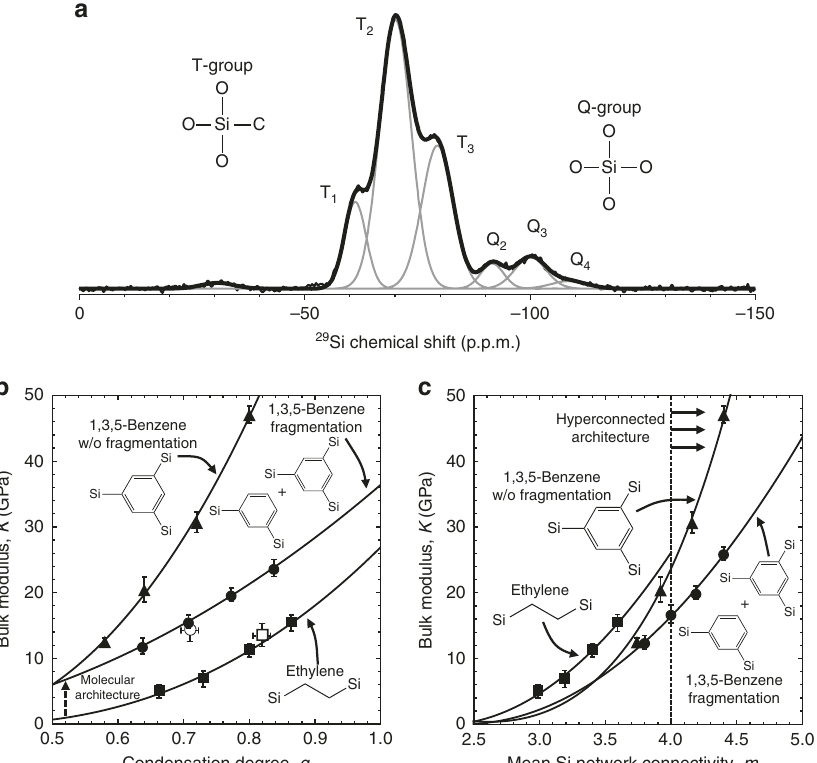
Fig. 2 Synthesized glasses calibrate and con fi rm computational models. a The 29 Si NMR spectra for glass processed from 1,3,5(triethoxysilyl)benzene shows the majority of silicon atoms are coordinated with three oxygen atoms and one carbon atom (T-group con fi guration), while 10.8% of the silicon atoms are coordinated with four oxygen atoms (Q-group con fi guration), indicating that some degree of precursor fragmentation occurred, creating SiO 2 and 1,3-benzene structural units. b The bulk modulus, K , of the pure 1,3,5-bridged MD model is plotted with respect to condensation degree, q . A 1,3,5-benzene glass is synthesized and characterized using NMR and SAWs and is plotted as the open circle. An MD model that includes precursor fragmentation (1,3,5-benzene and 1,3-benzene) is calibrated to the experimental data, where we plot the bulk modulus, K , with respect to condensation degree, q . The benzene-bridged models with and without precursor fragmentation show a signi fi cant increase in bulk modulus, K , compared to the ethylene-bridged model (calibrated with experimental synthesis and characterization that is plotted as the open square) 1 due to the change in the underlying molecular architecture that shifts the modulus to a higher base value (indicated by the dashed arrow). c The bulk moduli of the ethylene- bridged, 1,3,5-benzene-bridged, and fragmented 1,3,5-benzene-bridged MD model glasses are plotted against the mean Si network connectivity, m Si . Values of m Si > 4 (the chemical coordination number of Si) correspond to hyperconnected architectures as denoted by the dashed vertical line. The error bars denote one standard deviation of the mean of three trials per condition in b ,